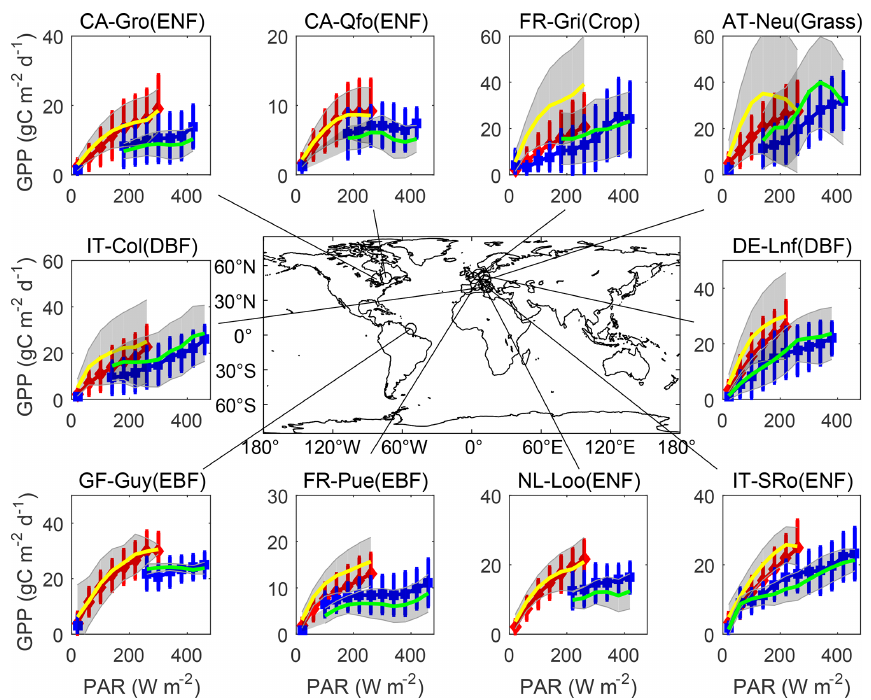
Figure 1. Simulated and observed GPP responses to direct and diffuse radiation. The comparisons are performed at 10 FLUXNET sites where more than 8 years of observations are available. For each site, hourly observations are divided into direct and diffuse conditions if diffuse fraction is < 0 . 2 (blue squares) and > 0 . 8 (red diamonds), respectively. The classified observations are averaged over PAR bins of 40Wm − 2 , with error bars indicating 1 standard deviation of GPP for each bin. Similarly, simulations are also divided into direct (green) and diffuse (yellow) bins of PAR, with gray shading indicating 1 standard deviation. The plant function types include evergreen broadleaf forest (EBF), evergreen needleleaf forest (ENF), deciduous broadleaf forest (DBF), grassland (Grass), and cropland (Crop). The site name and vegetation type are listed on the title of each